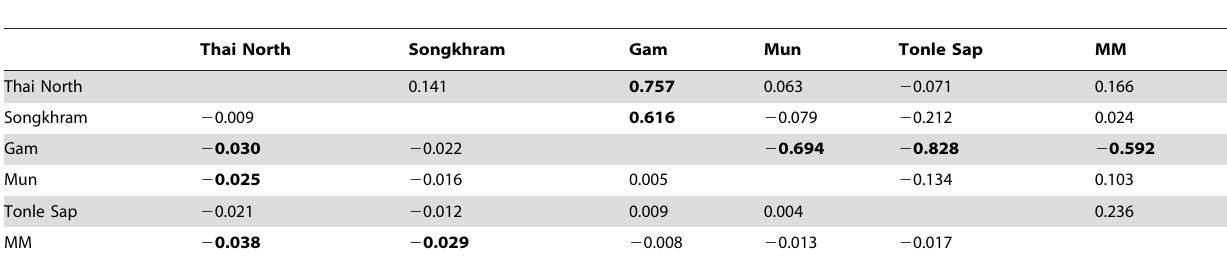
Table 4. Pairwise differences (mmol/mol) between regions in H. siamensis otolith core elemental signatures for Sr/Ca (above diagonal) and Ba/Ca (below diagonal).